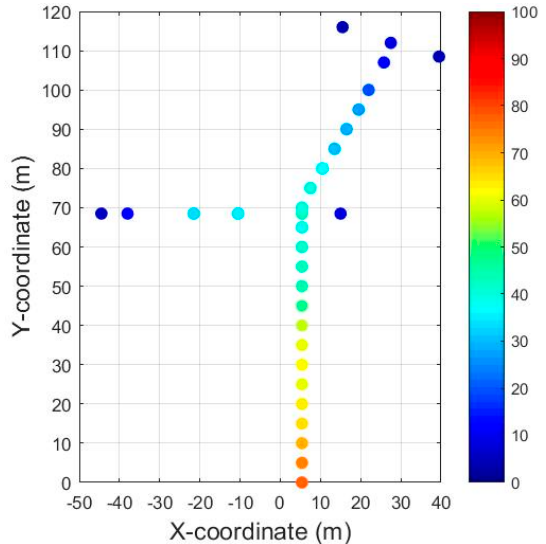
Figure 6. Scatter plots of PM 2.5 concentration at sampling sites in the passageway on 28 May (Sunday, Dragon Boat Festival).